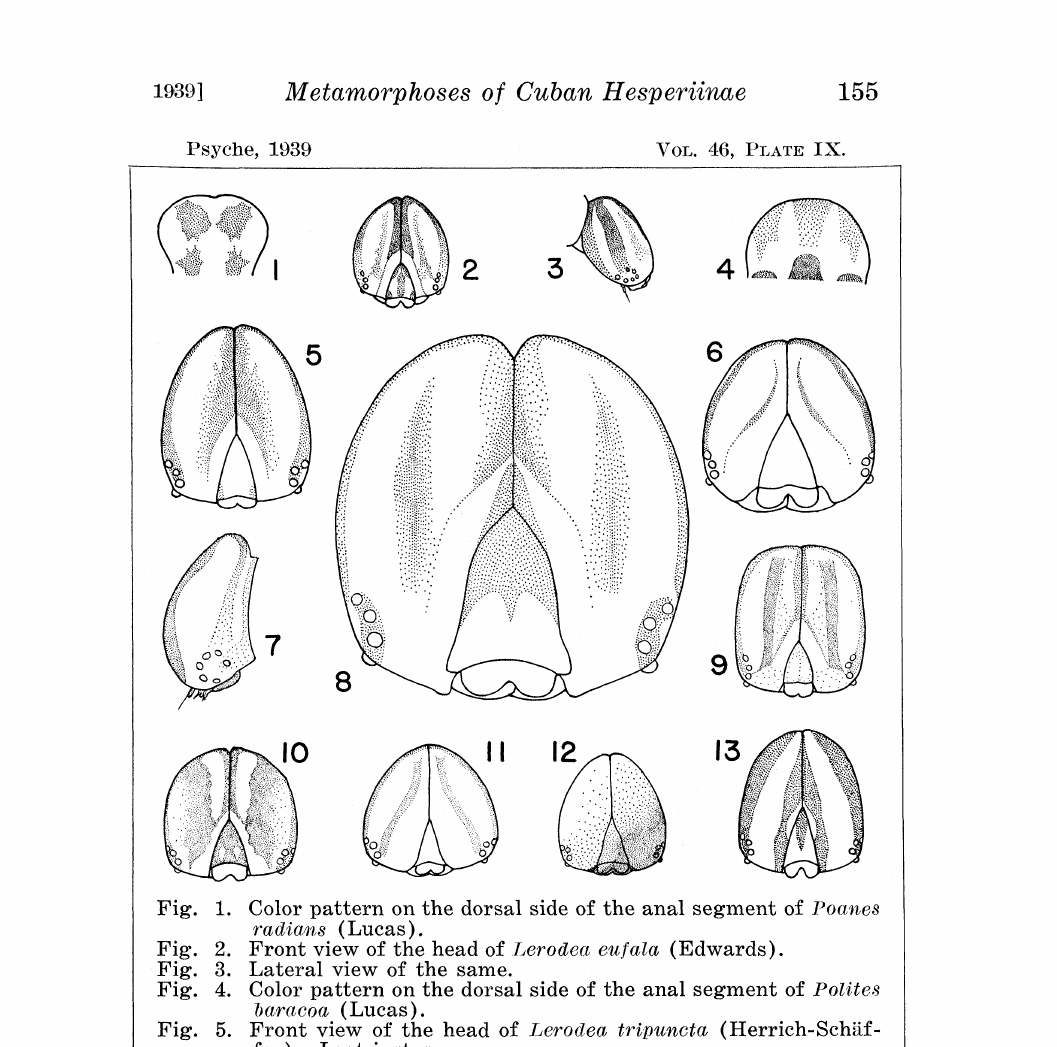
Color pattern on the dorsal side of the anal segment of Poanes radians Lucas Front view of the head of Lerodea e.ufala (Edwards). Lateral view of the same. Color pattern on the dorsal side of the anal segment of Polites baracoa (Lucas). Front view of the head of Lerodea trpuncta (Herrich-Schiif- fer). Last instar. Front view of the head of t’renes nero sylvicola (Herrich- Schffer) Fourth instar. Lateral view of the head of Poanes radians (Lucas). Fourth instar. Front view of the head of .Prenes n.yctelius co.sciwia, (Herrich- Sch:iffer) Last instar. Front view of the head of Poanes radians (Lucas). Fourth instar. Front view of the head of .Polites baracoa (Lucas). Fourth instar. Front view of the head of Prenvs nero sylvicola (Herrich- Schiffer) Third instar. Front view of the head of Hylephila phyleus (Drury). Fig. 12. Front view of the head of Catia misera (Lucas). Fourth Fig. 13.